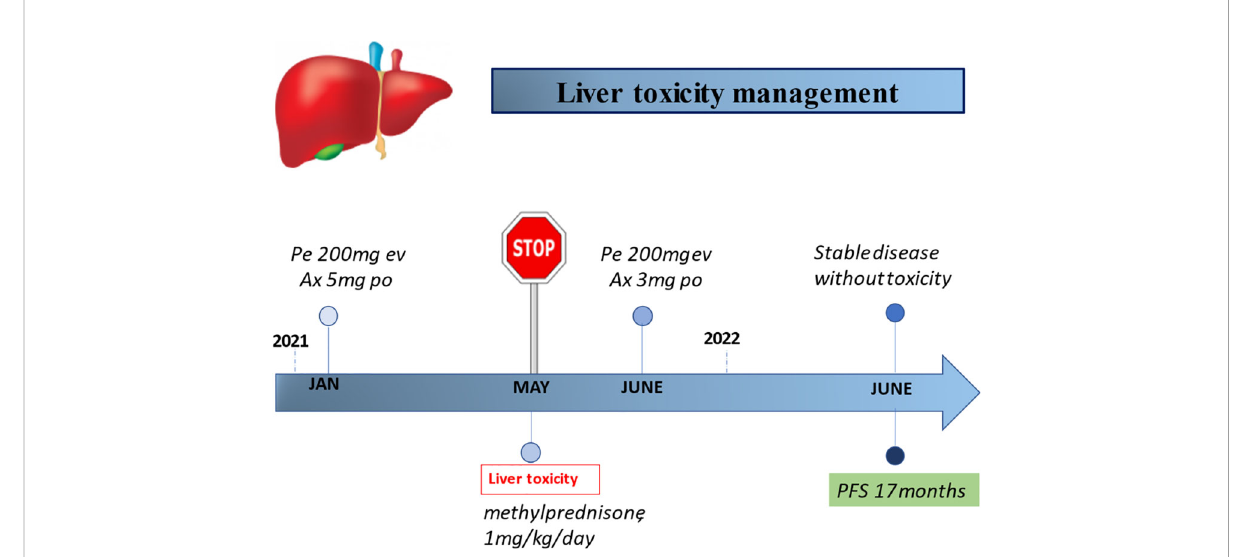
FIGURE 4 Timeline of the management of liver toxicity during ICI-based treatment. Pe, pembrolizumab; Ax,